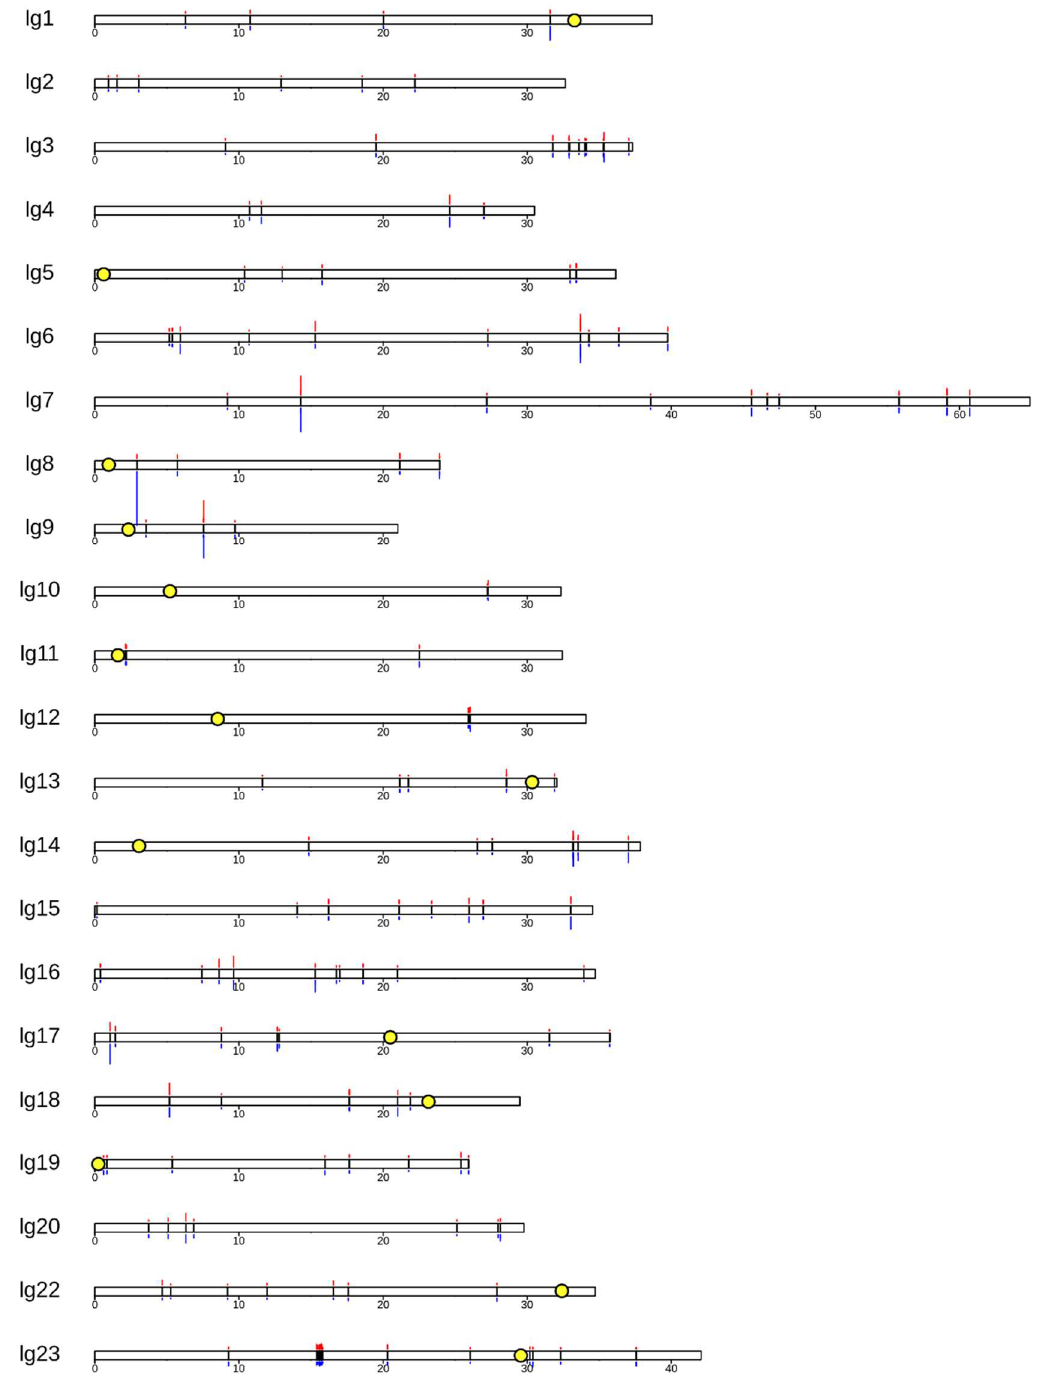
Figure 4. Karyoplot showing the A genome origins of the B chromosome. The position of B blocks (black bars) is superimposed on a karyoplot of the Metriaclima zebra “Mazinzi” reference genome. The A genome consists of 22 chromosomes. For simplicity, unanchored scaffolds of the genome assembly were not included. Physical distances are noted beneath each LG in Mb and the locations of centromeres (available for only some LGs) are indicated with yellow circles. Above and below each LG is a bar graph representing the scaled coverage ratio (SCR) of each core block. Above, in red, is the SCR of M . lombardoi 2014-1021. Below, in blue, is the SCR of L . trewavasae 2005-1306. The SCR of these individuals ranges from 3 to 234. The two individuals shown are arbitrarily chosen representatives of these two genera. This plot was created with the R package KaryoploteR [50].